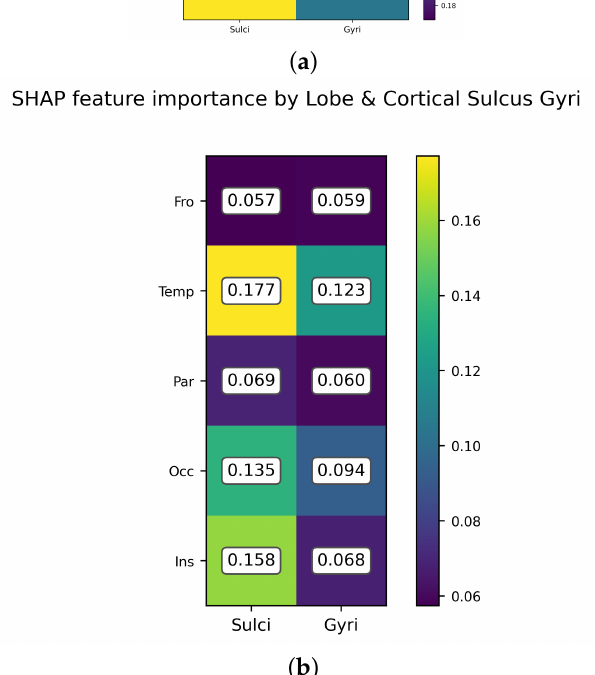
Figure 5. SHAP importance grouping cortical areas by hemisphere, lobe, and type of fold. ( a ) SHAP feature importance in relative terms for brain cortical areas depending on the hemisphere and the cortical surface type (sulci, gyri). As shown in the figure, the aggregate importance of sulci in the right hemisphere for predicting chronological age is 0.346 and is computed as the mean of the SHAP values of right sulci areas normalized by the total of sulci and gyri areas in both hemispheres. ( b ) SHAP feature importance in aggregate for brain cortical areas falling in brain lobes—frontal, occipital, parietal, temporal—and the insula. According to the SHAP values calculated, the temporal lobe contains more information for predicting age than the sulci and gyri-located regions in the other brain